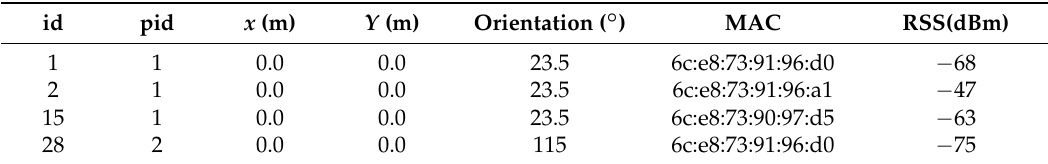
Table 1. The omnidirectional fingerprint